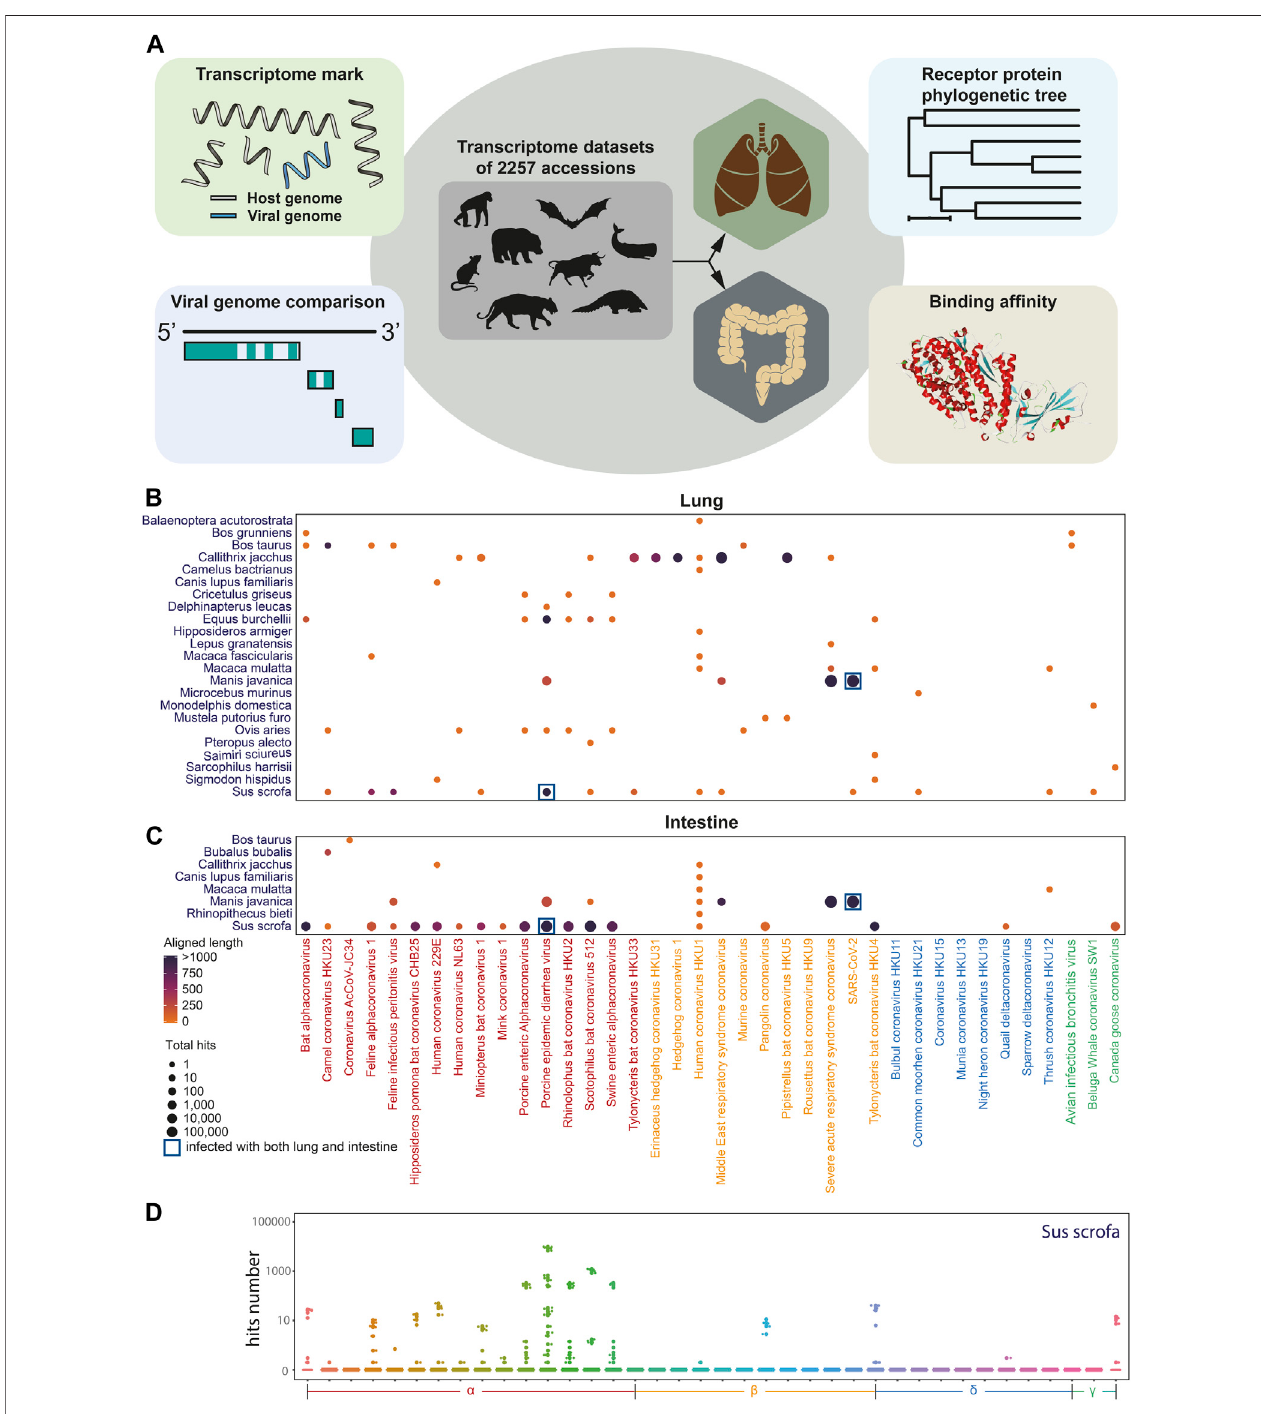
FIGURE 1 | Coronavirus infection landscape. (A) . Diagram of coronavirus in silico infection analysis in wild animals including coronavirus genome screening, genomecomparisonandphylogenetictreeanalysis,viralreceptorgenesexpressionanalysis,andviralligand – receptorbindingaf fi nityanalysis. (B) Coronavirusinfection landscape of mammals ’ lung and intestine. The size of dots represented the total hits that aligned to the coronaviral genome and the color of dots represented the total aligned length. Navy blue square frame demonstrates the species infected with coronaviruses in both the lung and the intestine. (C,D) Box plot of aligned hits number with Sus scrofa as